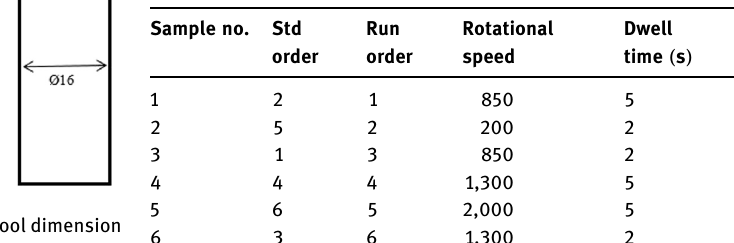
Figure 1: ( a ) Schematic diagram of lab joint ( mm ) ; ( b ) tool dimension ( mm ) .